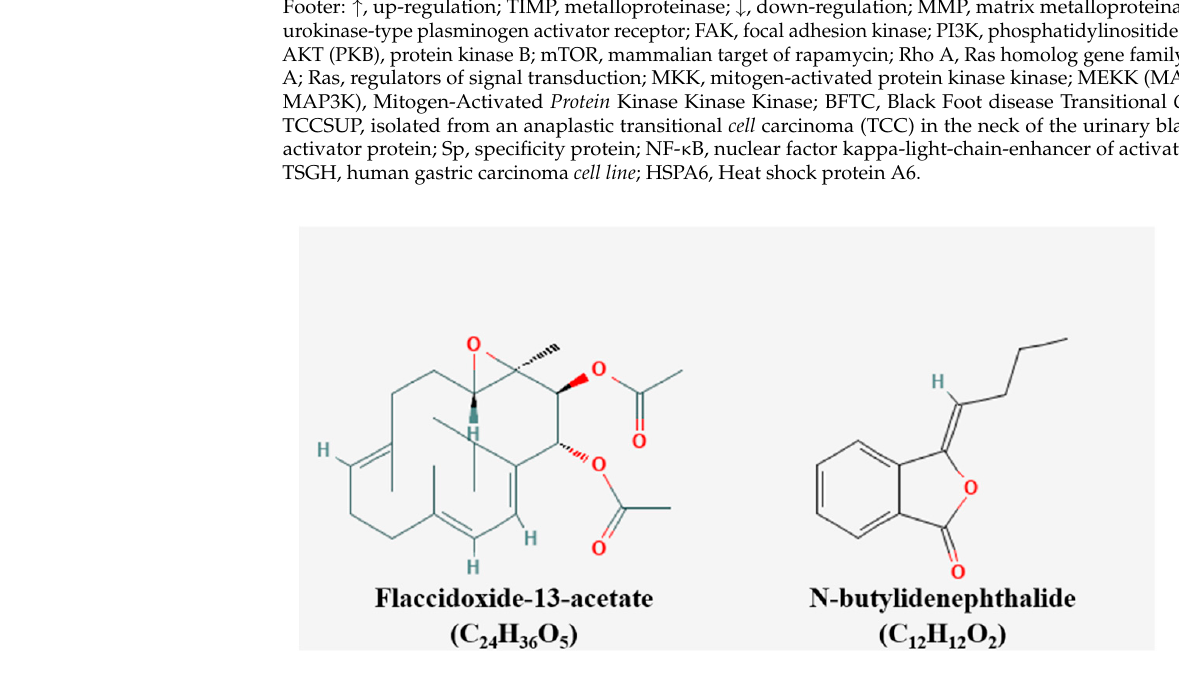
Figure 3. Chemical structures of compounds inhibiting metastasis.